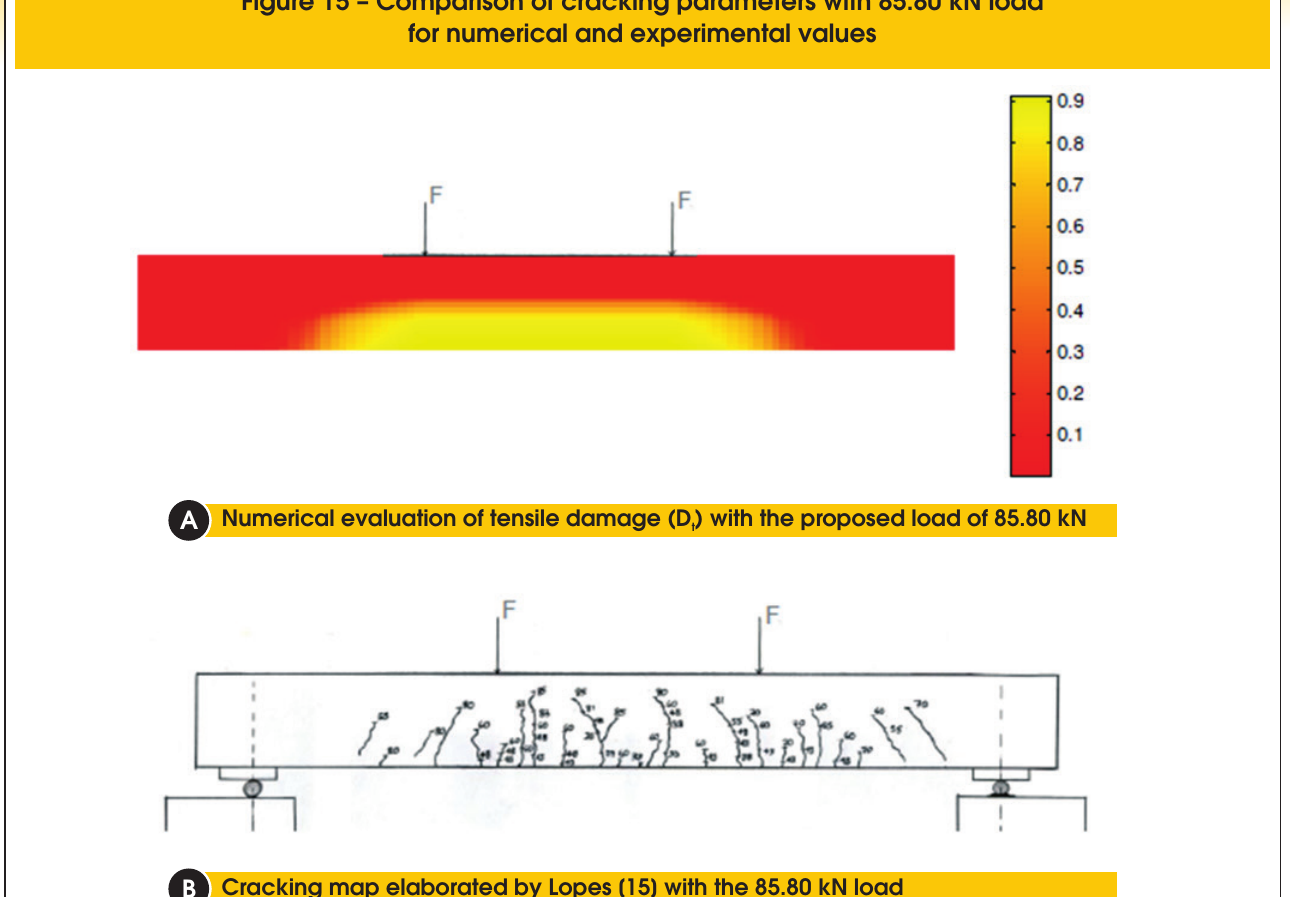
Figure 15 – Comparison of cracking parameters with 85.80 kN load for numerical and experimental values